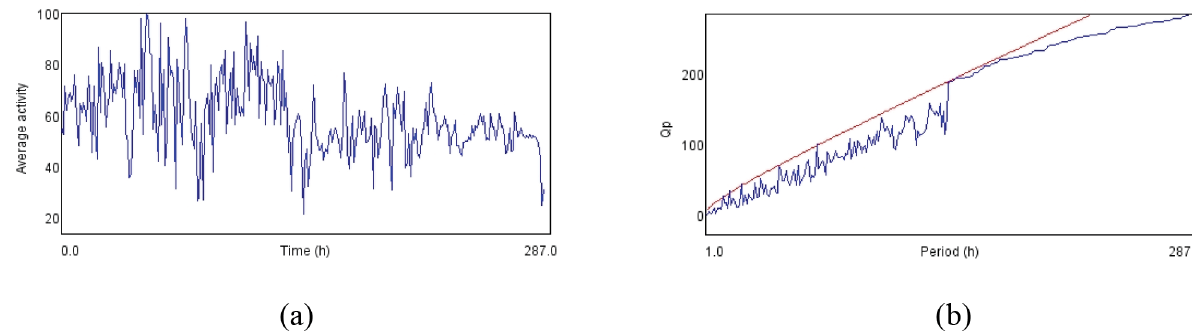
FIGURE 5S - (a) and (b) shows the average activity pattern and chi-square periodogram respectively for PD flies exposed to luteolin (25 µM).